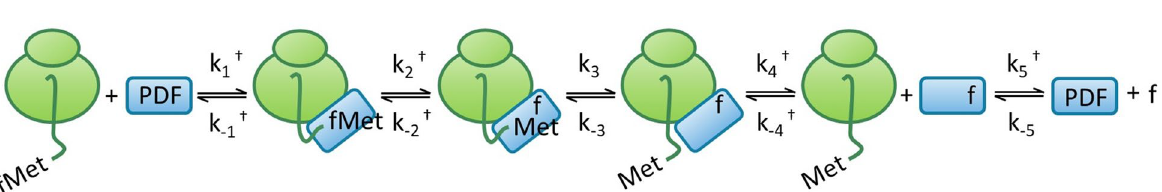
Figure 5. Minimal kinetic model of deformylation. Rate constants obtained from association experiments (Table 2), estimated from single-turnover experiments (Fig. 2) or found to be rapid but non-defined were kept fixed ( † ) during fitting. The remaining time courses were globally fitted to multiple- and single-turnover kinetics from TolB75-RNC, DnaK75-RNC, RNaseH75-RNC and proOmpA75-RNC (Fig. 6). f represents the formyl